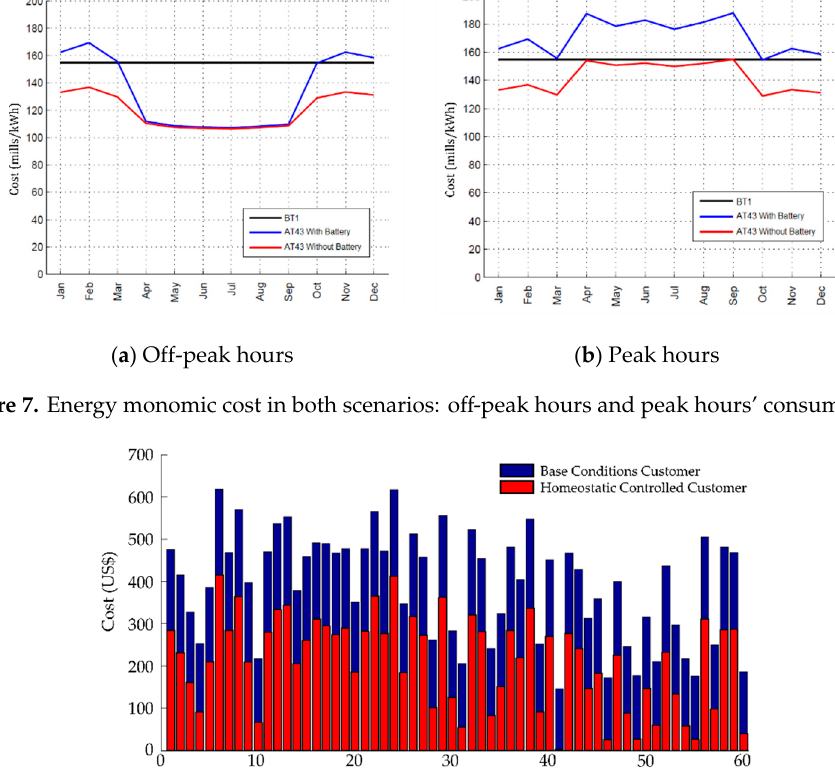
Figure 8. Annual energy cost per client under A criterion.